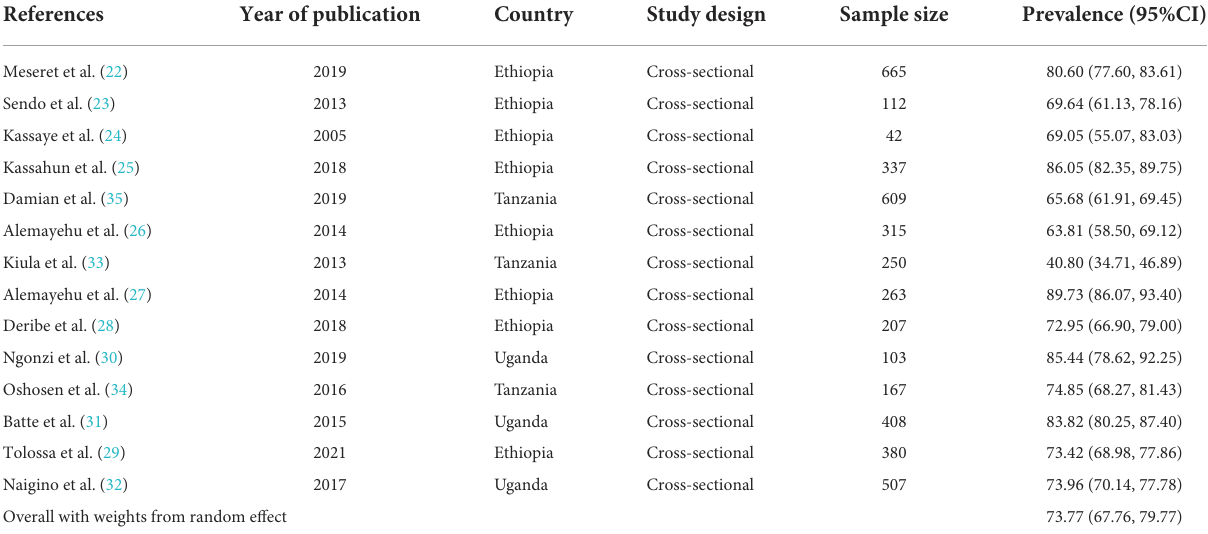
TABLE 1 Summary of included studies on magnitude of HIV sero-status disclosure among women in East Africa, 2021.